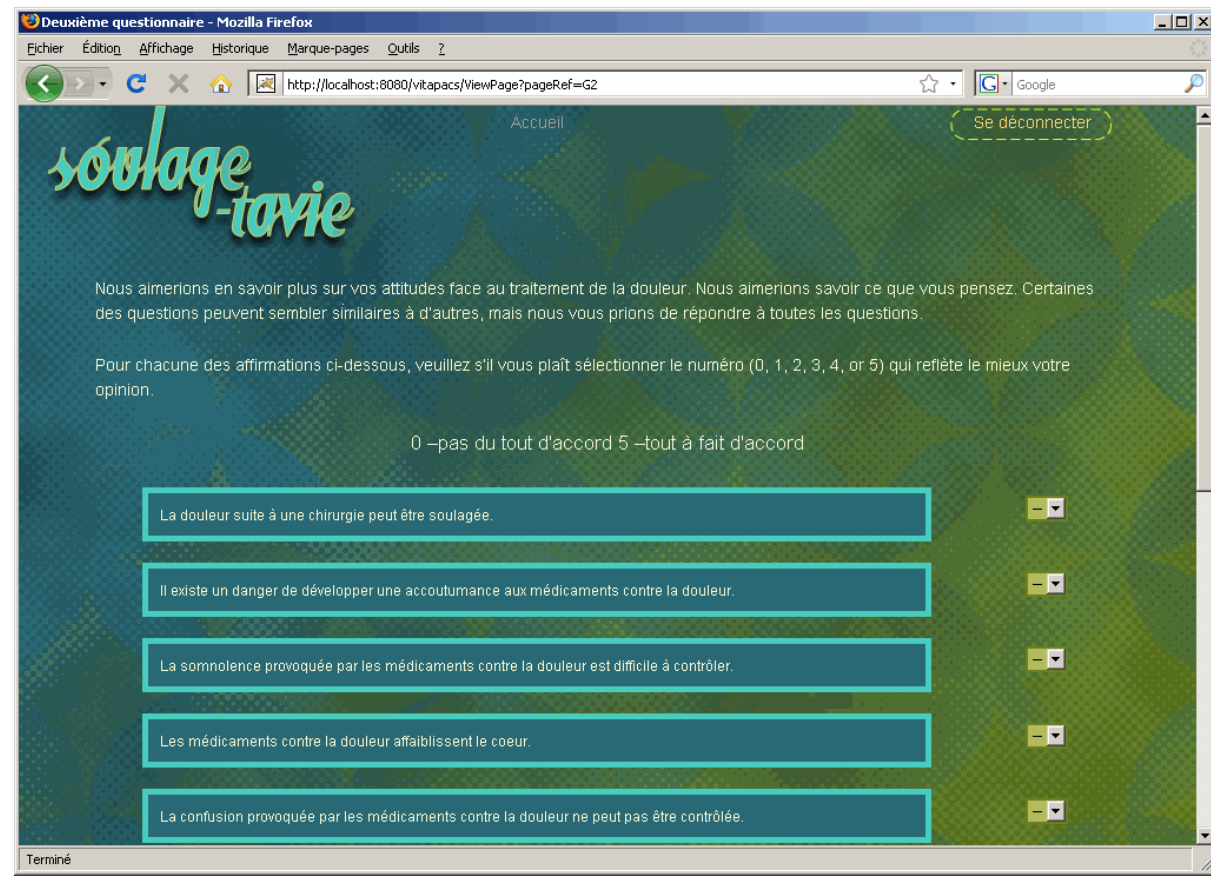
Figure 2. Screening page of the SOULAGE-TAVIE